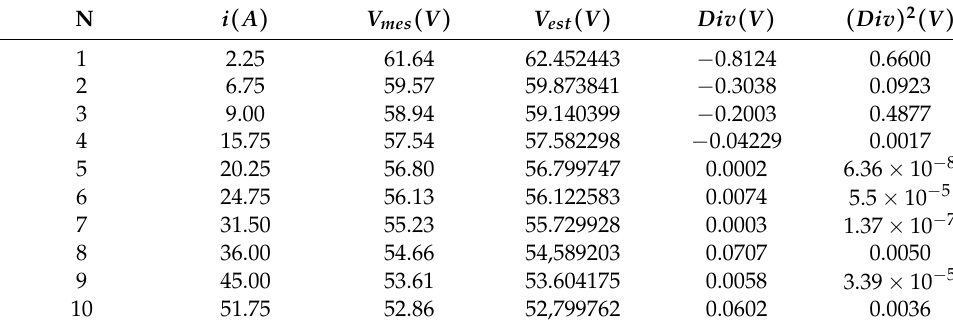
Table 8. Estimated voltage and absolute deviation of the NedStack